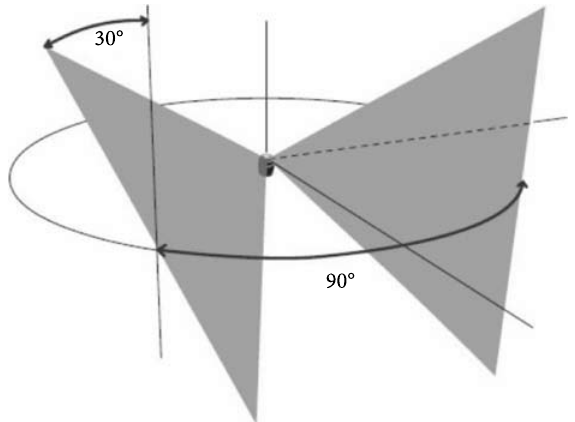
fig. 4. The 2 rotating fan-shaped laser planes of iGPS, graphic from Metris